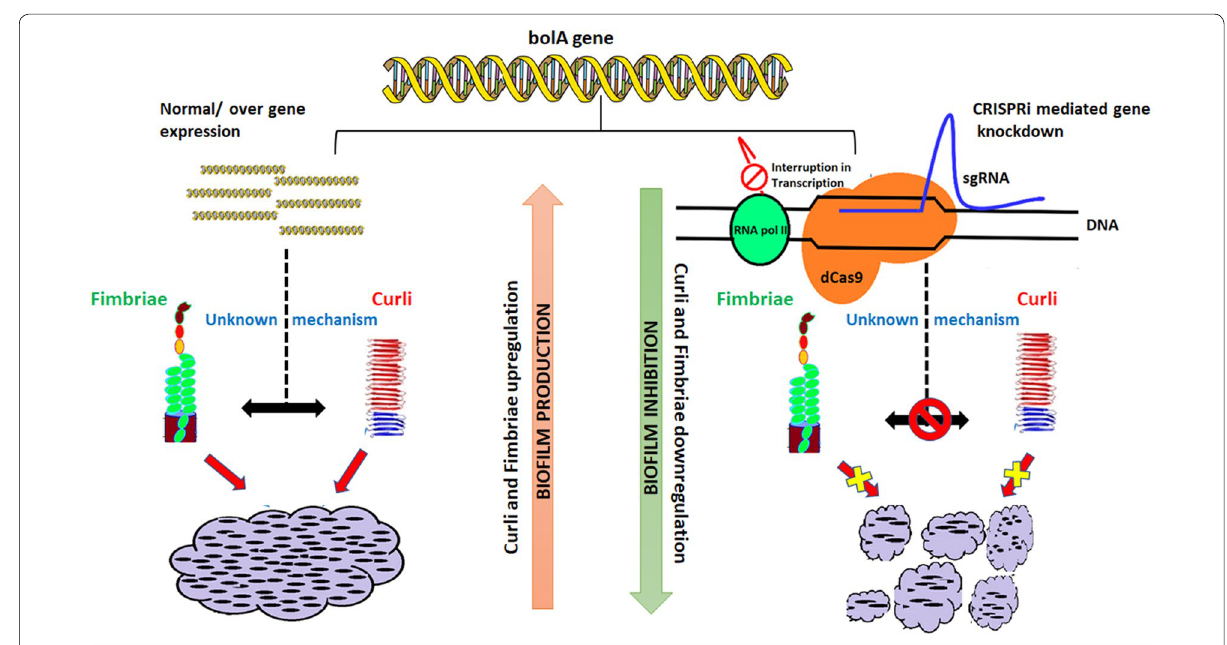
Fig. 6 The proposed model of the